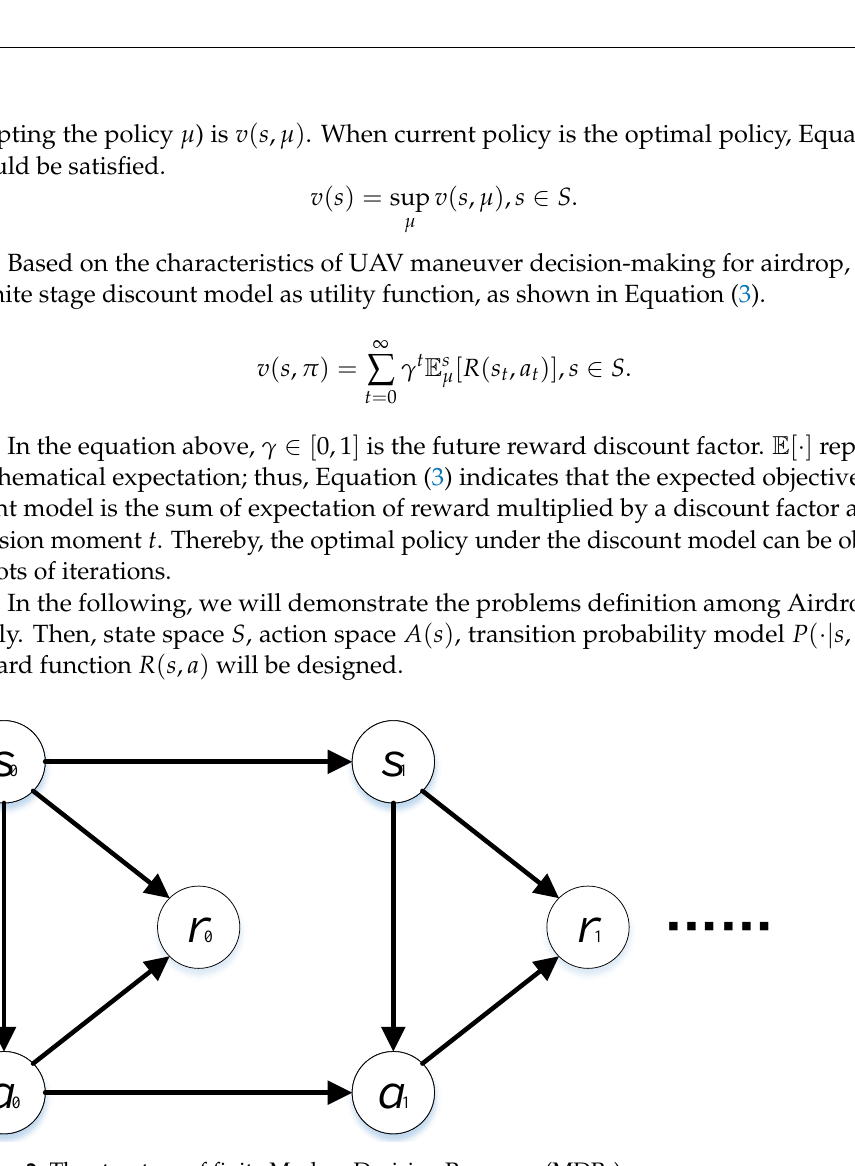
Figure 2. The structure of finite Markov Decision Processes